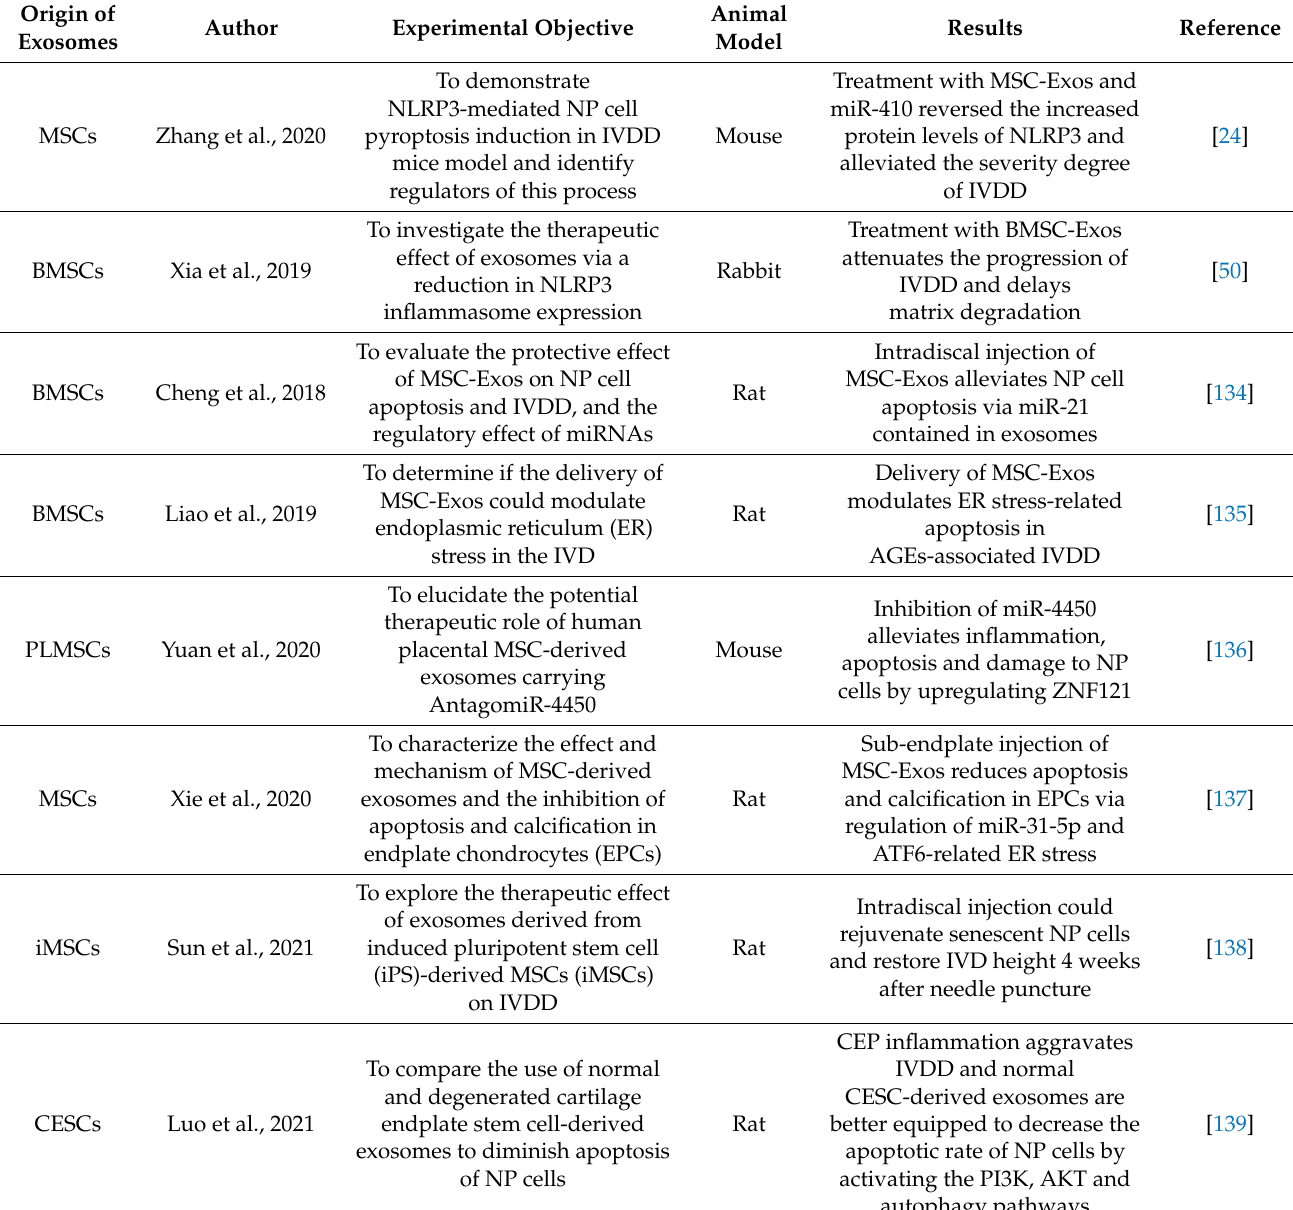
Table 2. In vivo studies utilizing stem-cell derived exosomes for IVDD